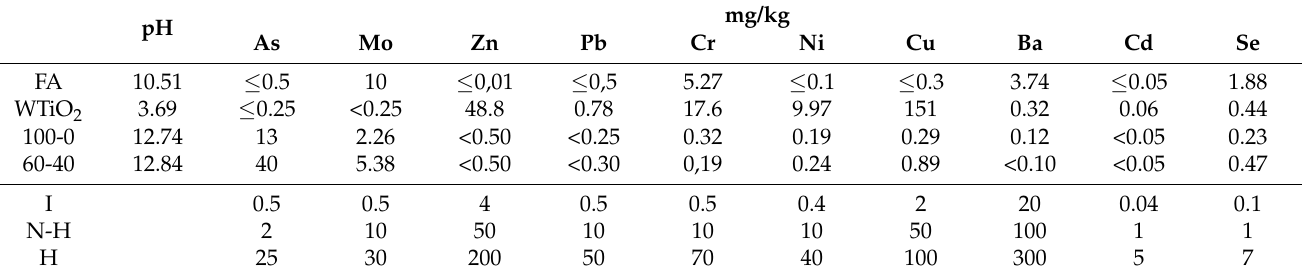
Table 5. EN 12457-4 leachability values and limits of different standards (mg/kg, dry base). mg/kg